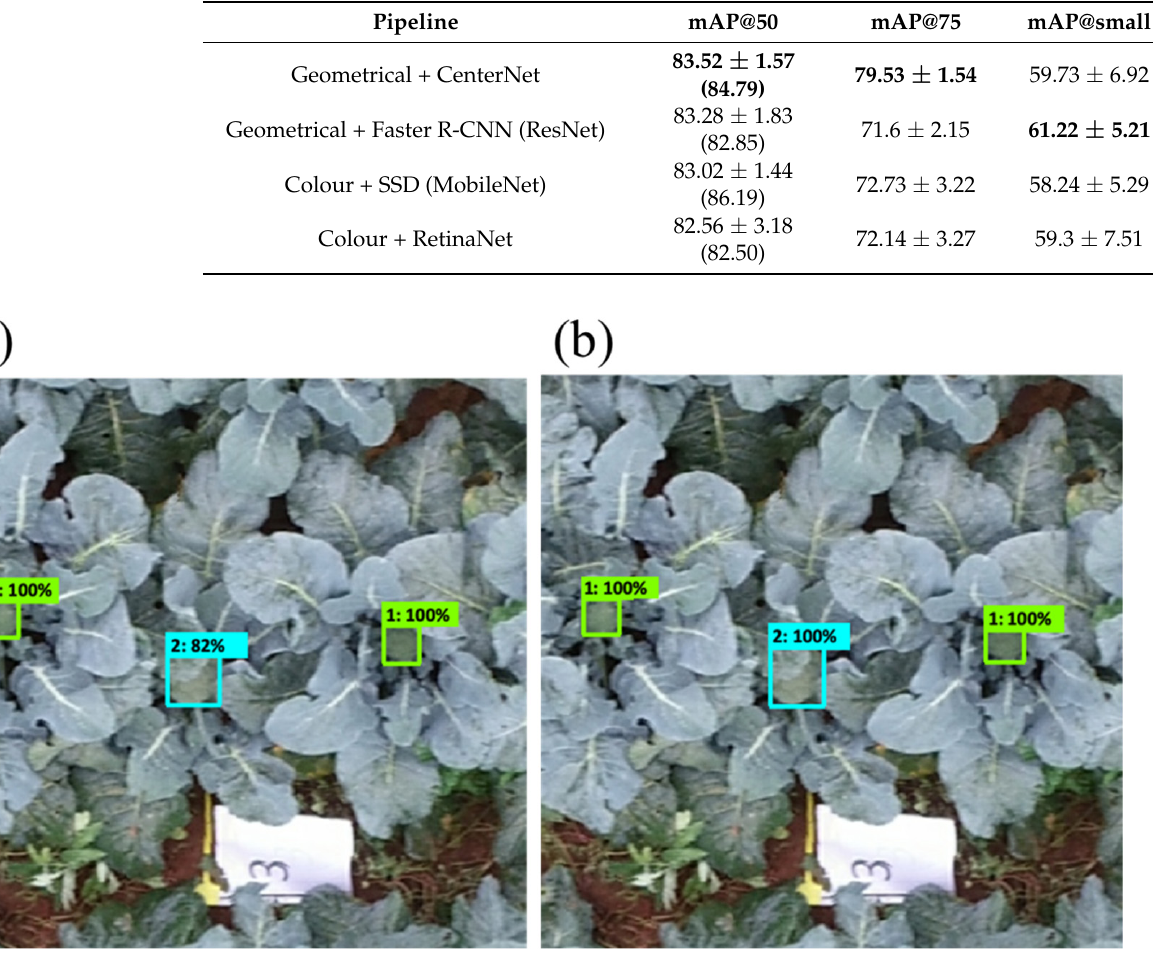
Figure 12. Examples of ( a ) broccoli head detections and ( b ) ground truth labels using the two-class approach.